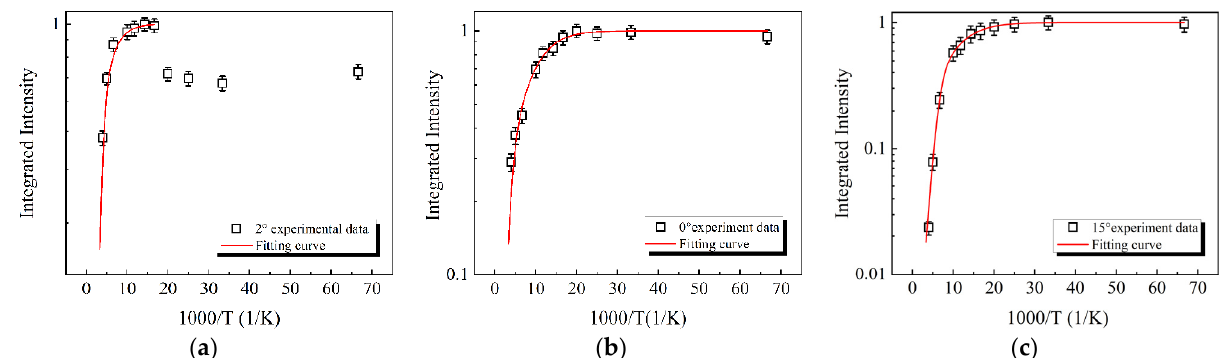
11 of 15 Figure 10. Relationship between photon energy and FWHM for the 2° sample. The red solid line represents the curve fit to the presented data. The temperature-dependent PL intensity data can be fit using the Arrhenius equation shown below to study the mechanism of PL quenching with increasing temperatures [44]: ( ) (8) I ( T ) represents the integrated PL intensity at temperature T , C i represent the factors related to the densities of nonradiative recombination centers, and E i represent the activa- tion energies of the relevant nonradiative recombination centers. Two types of nonradia- tive recombination channels have been proposed for the quenching mechanism of PL in- tensities in epitaxially grown materials. The modified Arrhenius equation used to fit these experimental data can be expressed as [45–47]